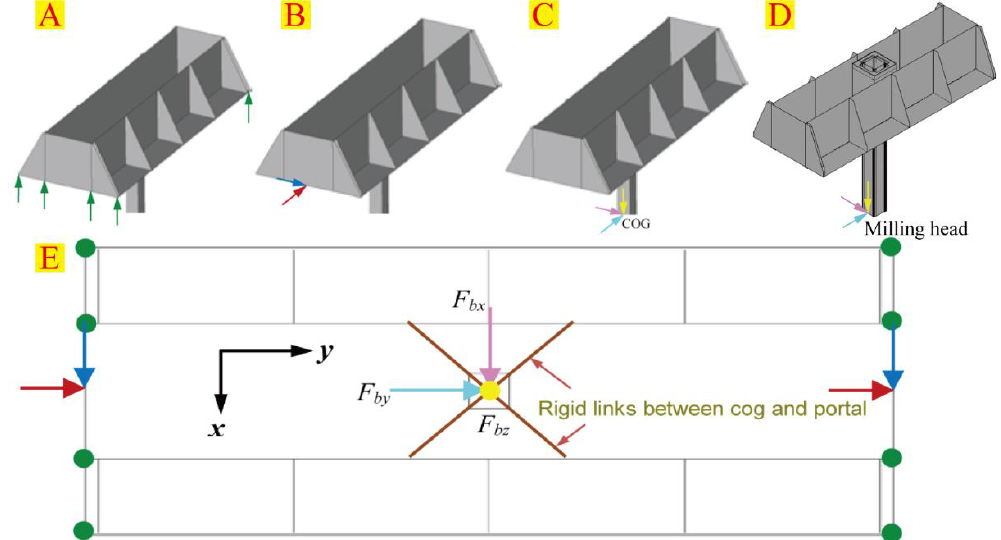
Figure 5. Boundary conditions for composite framework: ( A ) marked positions of vertical support of the portal; ( B ) marked positions of horizontal support of the portal; ( C ) forces direction in the center gravity (COG) of the traverse and lifting beam; ( D ) forces direction in milling head; ( E ) the top view of all boundary